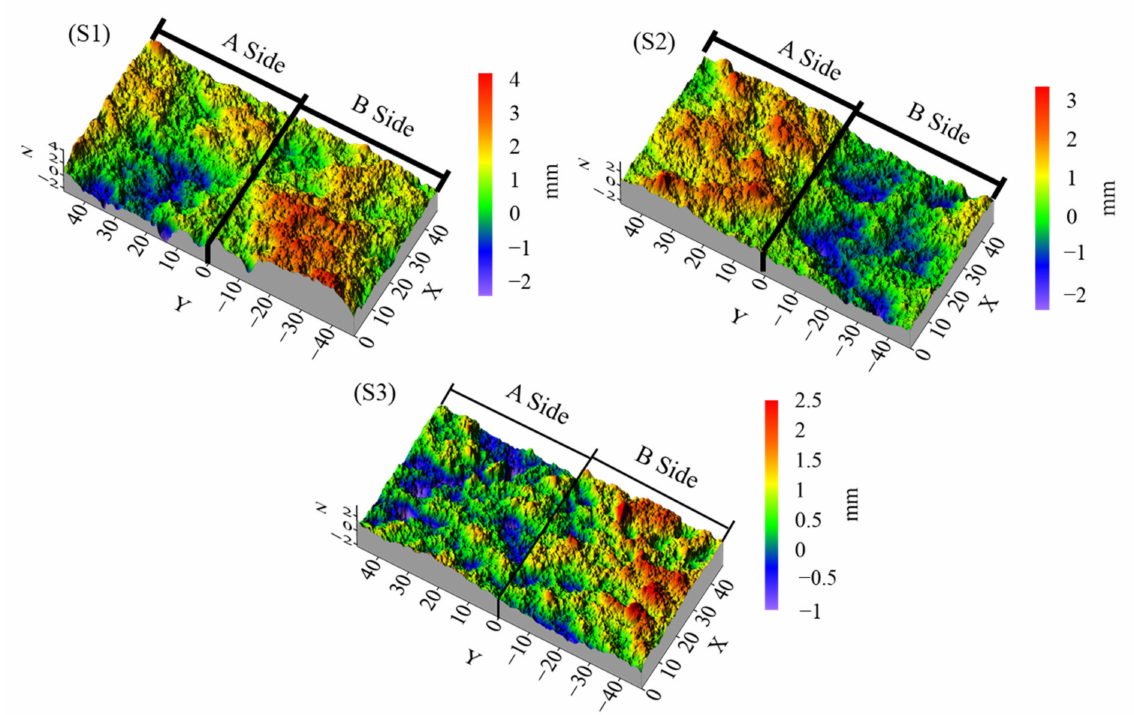
Figure 5. Geometry of concrete samples used in this